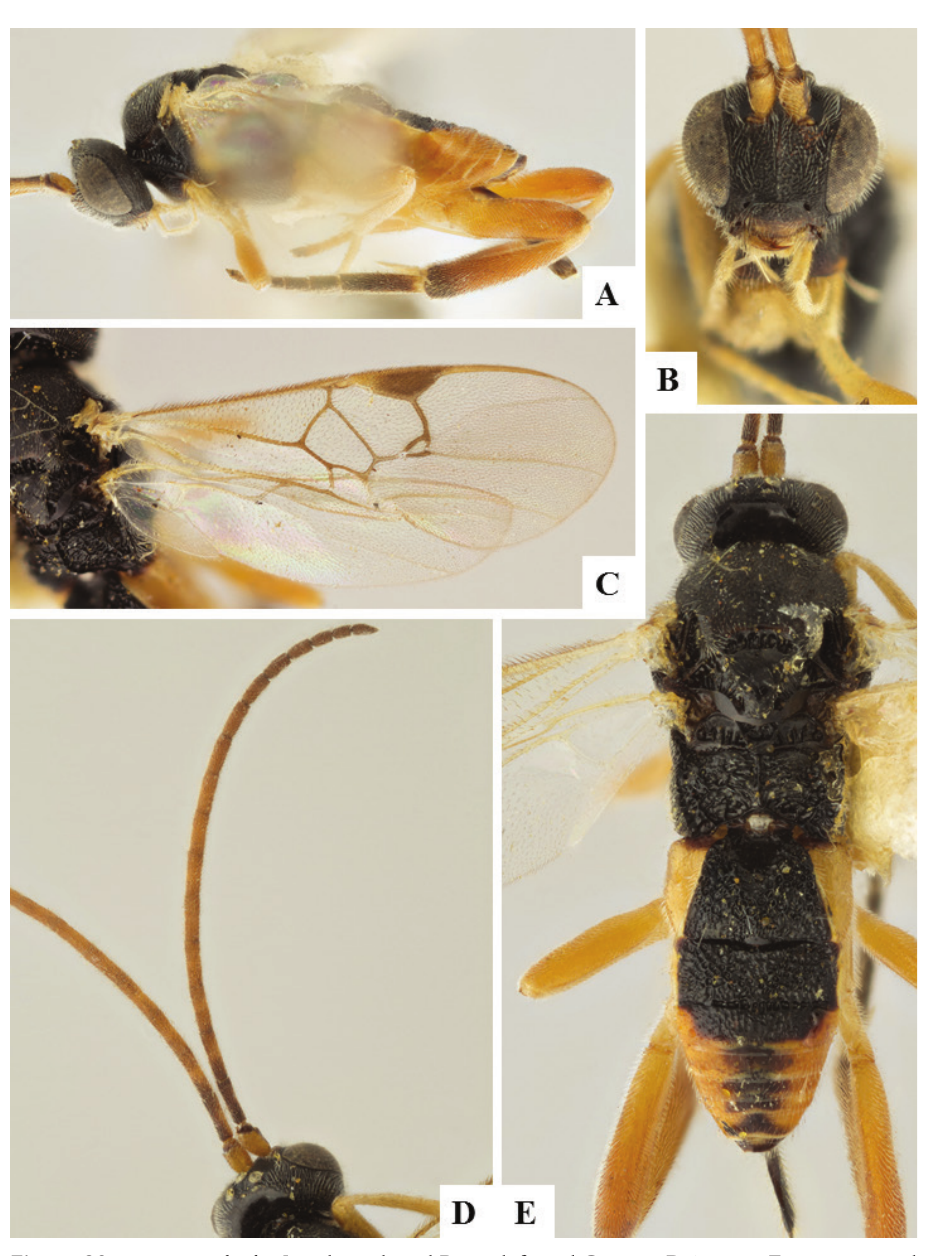
Figure 29. Microgaster leechi. A Habitus, lateral B Head, frontal C Wings D Antenna E Mesosoma and metasoma,